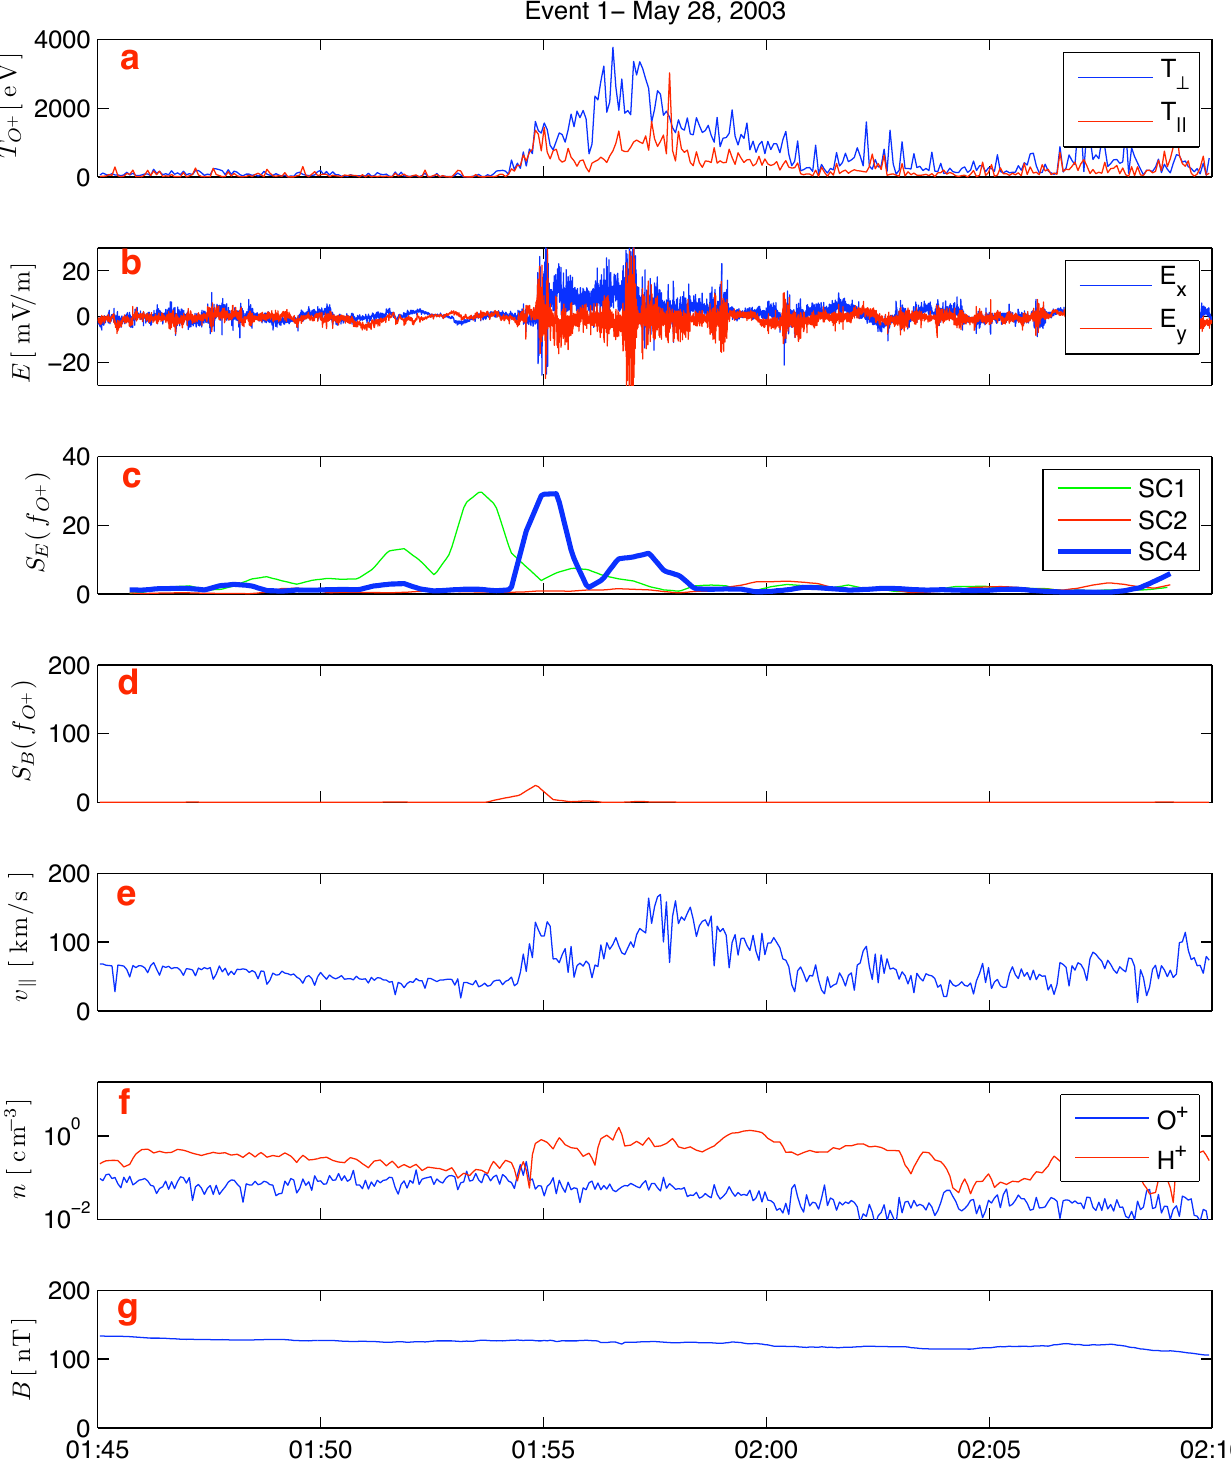
Fig. 2. SC4 measurements for Event 1 (28 May 2003): Panel (a) shows the perpendicular (blue) and the parallel (red) O + temperatures, panel (b) the electric field for the two components measured in the satellite spin plane, panel (c) the power spectral density at f O + for the electric field given in (mVm − 1 ) 2 Hz − 1 measured by different spacecraft (the blue line corresponds to SC4), panel (d) the power spectral density at f O + for the magnetic field given in (nT) 2 Hz − 1 , panel (e) shows the O + parallel velocity, where the outflow is defined to be positive, panel (f) the number densities for O + (blue) and H + (red), and panel (g) the magnitude of the background magnetic